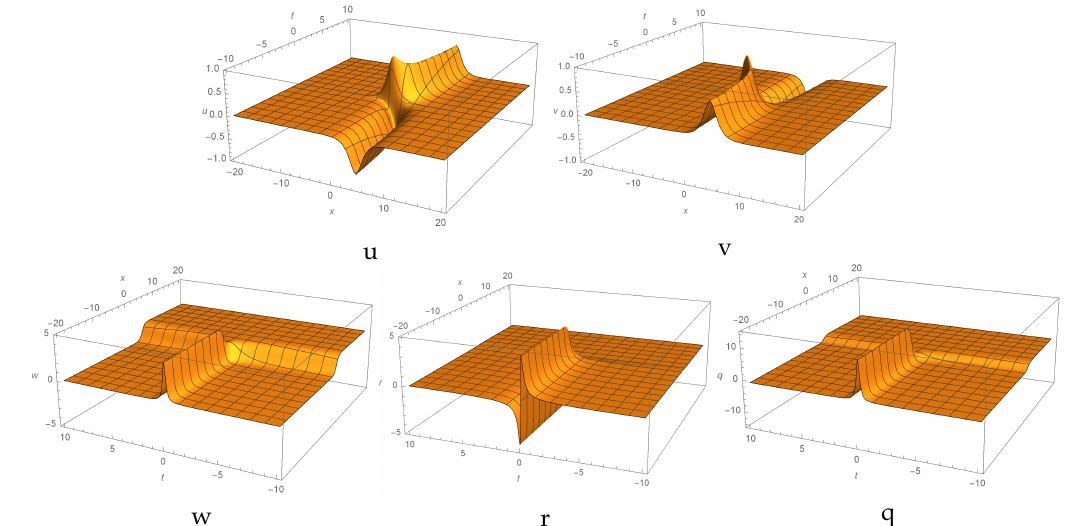
Figure 2. A solution that is a rational function of e x and t